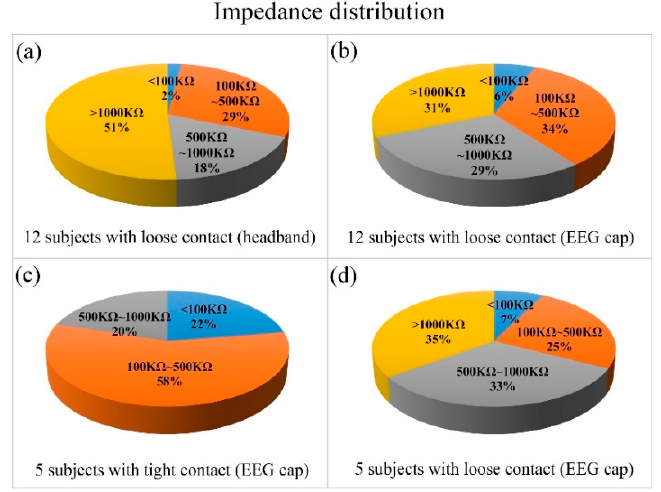
Figure 6. The impedance value distribution of ( a ) 12 subjects under loose contact with a headband; ( b ) 12 subjects under loose contact with the EEG cap, ( c ) 5 subjects under tight contact with the EEG cap ( d ); and 5 subjects under loose contact with the EEG cap.